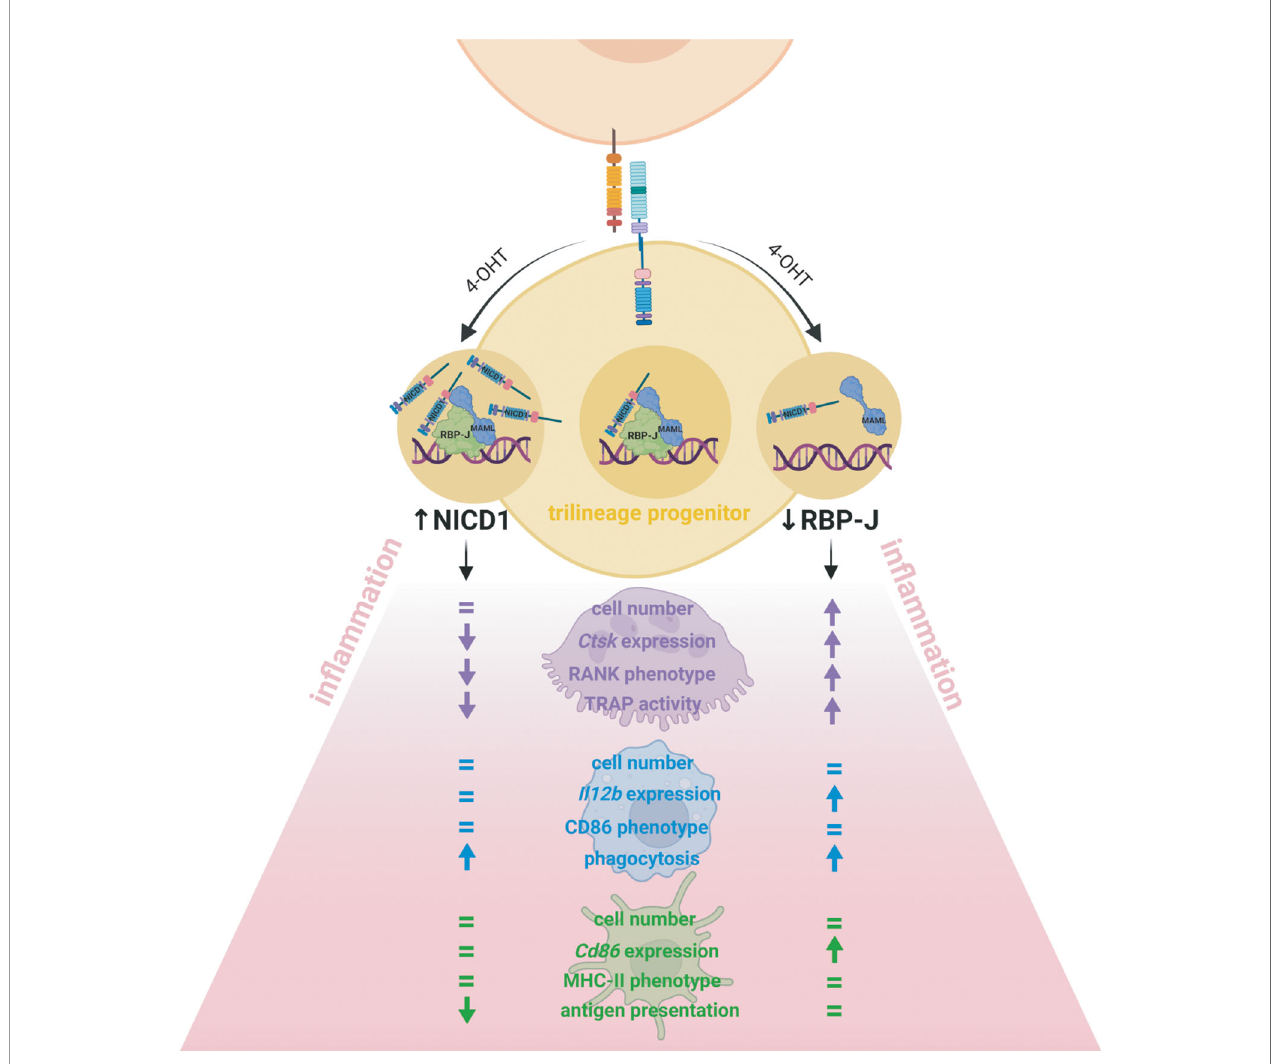
FIGURE 8 | Effect of Notch signal modulation on the bone marrow trilineage progenitor (TLP) in the in fl ammatory context. Conditional inducible transgenic mouse strain in which expression of the Cre recombinase is driven by the monocyte marker CX3CR1 was crossed with either a mouse strain in which Notch receptor 1 intracellular domain (NICD1) is overexpressed or a mouse strain in which the transcriptional factor RBP-J is deleted upon Cre-mediated recombination. The transgene was activated in vitro , by 4-hydroxytamoxifen (4-OHT) treatment of isolated TLPs, from the beginning of differentiation. The effects of Notch modulation were assessed by cell proliferation, differentiation gene expression, LPS-stimulated activation phenotype and functional assays, and the major fi ndings are schematically presented. The clearest effect was observed in cells of the osteoclast lineage. Deletion of RBP-J involved in Notch canonical signaling enhanced osteoclast progenitor proliferation and osteoclast Ctsk differentiation gene expression as well as RANK abundance and TRAP activity, whereas NICD1 overexpression had the opposite effects. The macrophage lineage responded to RBP-J deletion by upregulation of Il12b differentiation gene expression, without signi fi cant difference in the activation phenotype. However, both NICD1 overexpression and RBP-J deletion enhanced LPS-induced phagocytosis, indicating that other pathways beside Notch critically regulate macrophage activity. The Notch pathway seems to be less active during dendritic cell commitment from TLP, so Notch modulation did not affect dendritic cell proliferation and their activation phenotype but had a moderate effect on Cd86 differentiation gene expression. However, in the functional assay, mature dendritic cells overexpressing NICD1 showed diminished activation markers and a reduced antigen-presenting